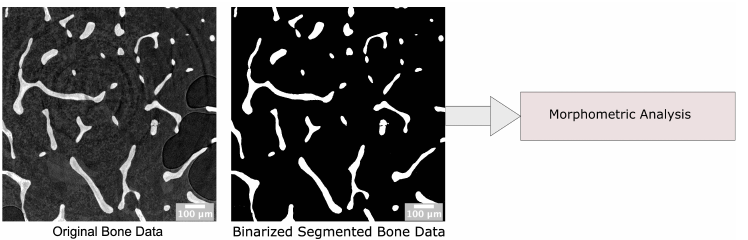
Figure 9. The protocol used for the application of the Morphometric Analysis on bone data. The anal- ysis is done on the binary segmented data to separate the bone phase. The size of the volumetric data set is 1178 × 1178 × 200 voxels with an isotropic voxel size of 5.0 µ